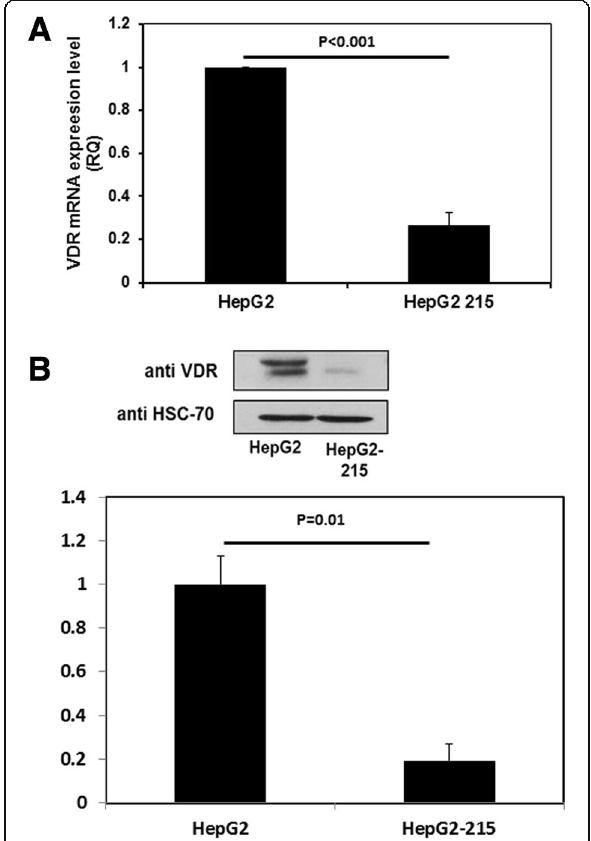
Fig. 2 VDR transcript and protein levels were lower in HepG2 – 2.15 compared to HepG2 cells. HepG2.2.15 and HepG2 cells were harvested and the levels of VDR RNA ( a ) and protein ( b ) were measured using RT-PCR and western blot analysis, respectively ( p <0.001). The western blot presented in the figure is a representative of three different experiments; all of these experiments were calculated in the quantification. Results are expressed as mean±standard